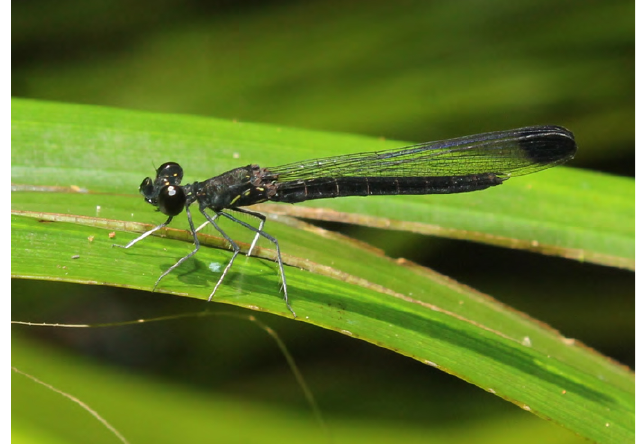
Figure 1. Libellago corbeti ♂ .